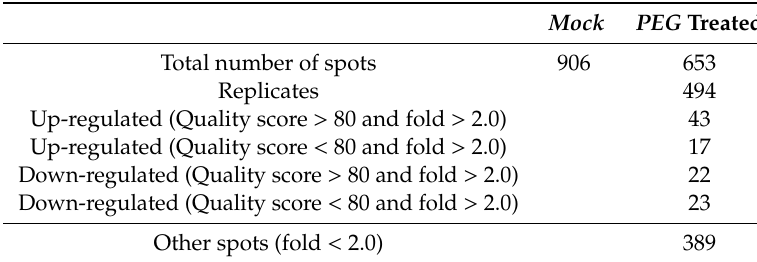
Figure 3. Two-dimensional gel analysis with proteins isolated from root of normal sorghum seedling (M-root-24 h) or root of PEG-6000 treated sorghum seedlings (T-root-24 h) and harvested at 24 h posttreatment: the arrows point to protein spots (automatic allocation of protein serial number by PDQuest Software) with altered expression levels (fold change > 2.0, quality score > 80, and p < 0.05) and were selected for MALDI-TOF-TOF MS analysis. Table 1. Average number of protein spots revealed after 2-DE of sorghum seedlings treated with 10% PEG-6000 at 24 h posttreatment: the total numbers of up- or downregulated spots were obtained after matching between control (CK) and treated with 10% PEG-6000 gels. The results are means of three independent